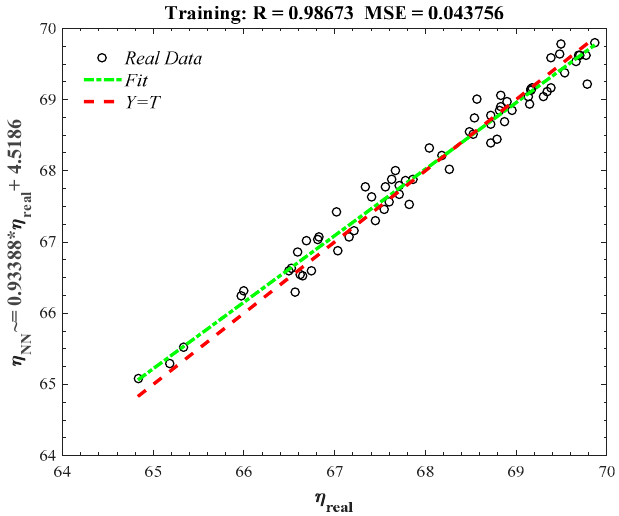
Figure 9. The regression line diagram for training data. MSE: Mean squared error.